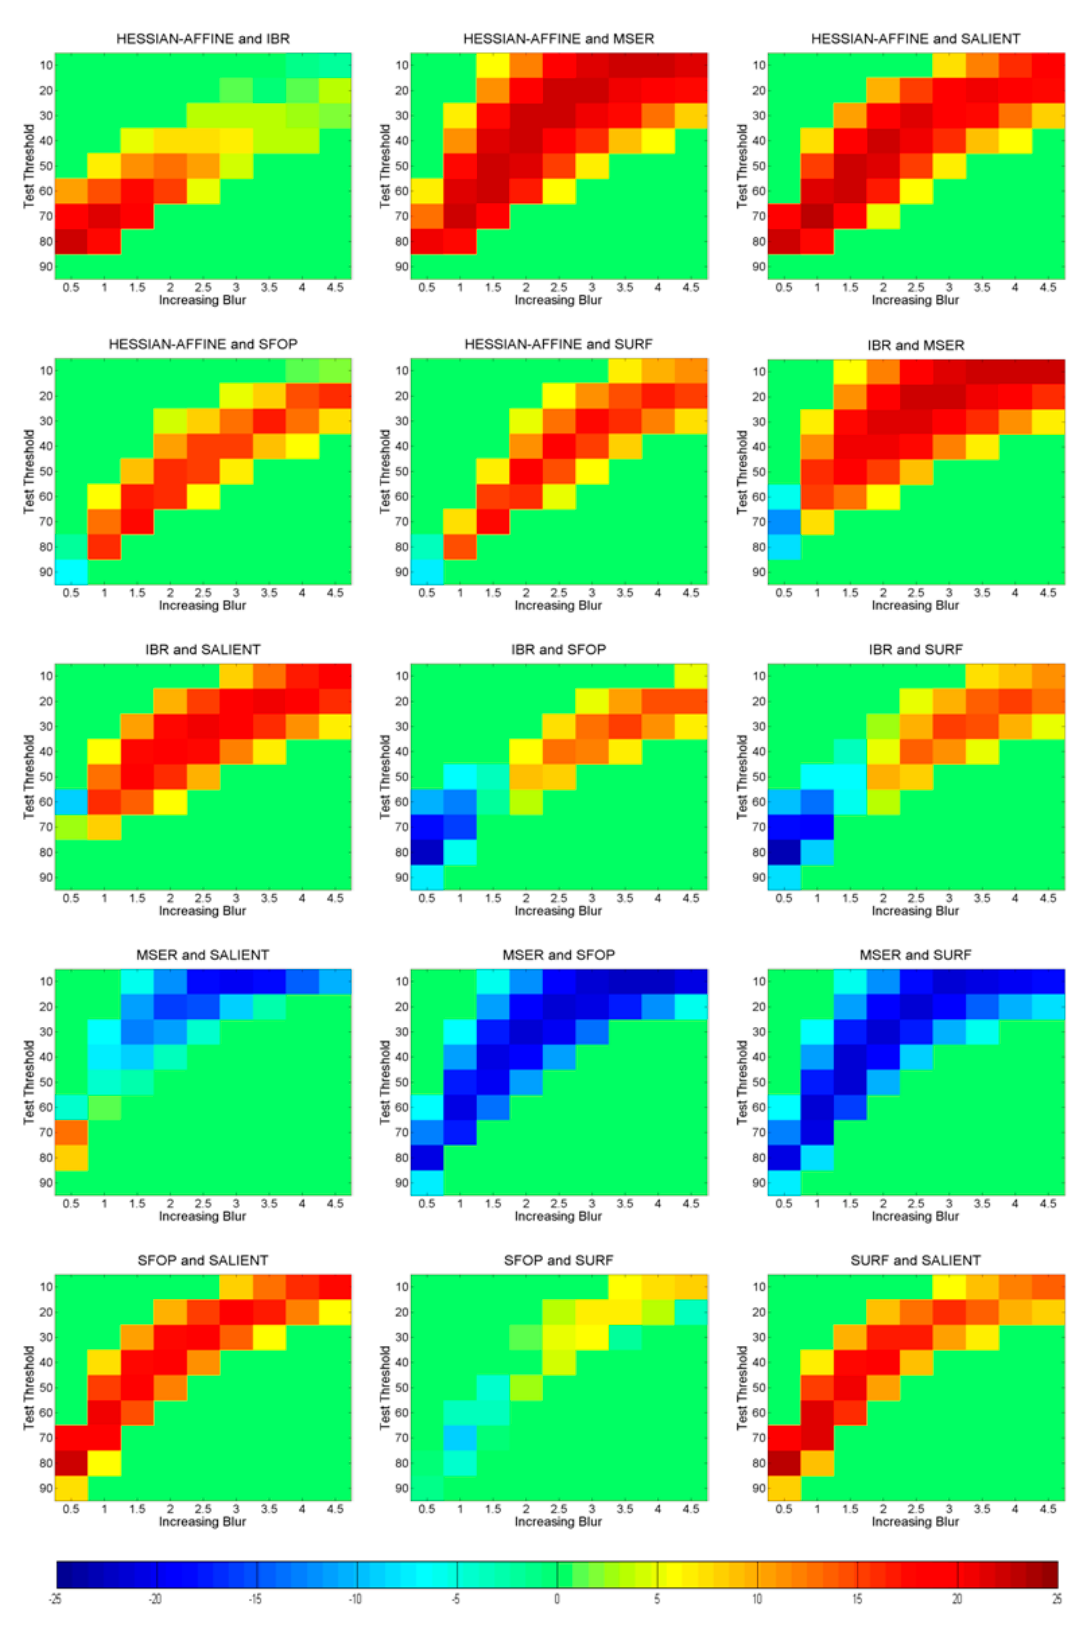
Figure 15. Results of blur changes for Hessian-Affine, IBR, MSER, SFOP and SURF with other detectors showing Z -scores; positive Z -scores show that the first detector is better than the second whereas negative values show the converse.